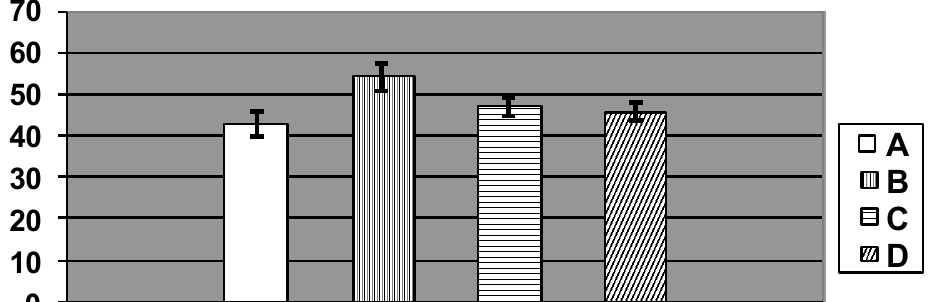
Figure 3. Number of Kupfer cells per 100 liver cells in rats exposed (A) to water (control); (B) to water suspension of copper oxide nanoparticles; (C) to the same against the background of BPC administrations; and (D) to the BPC only. (Average values with 95% CI). Differences are statistically significant between (B) and (A), and between (C) and (B) ( p < 0.05 by Student’s t